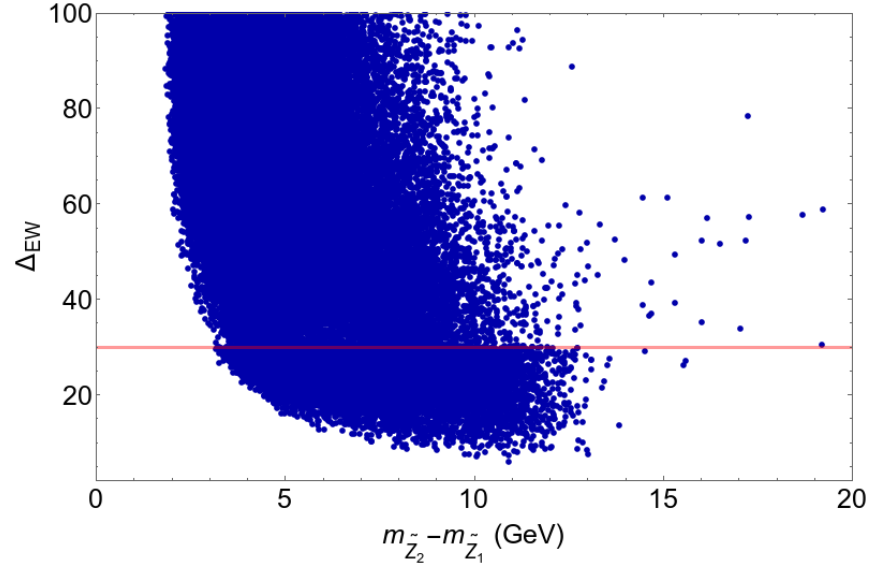
Figure 15 . Plot of (cid:1) EW vs. m with m 0 (1 ; 2) ’ m